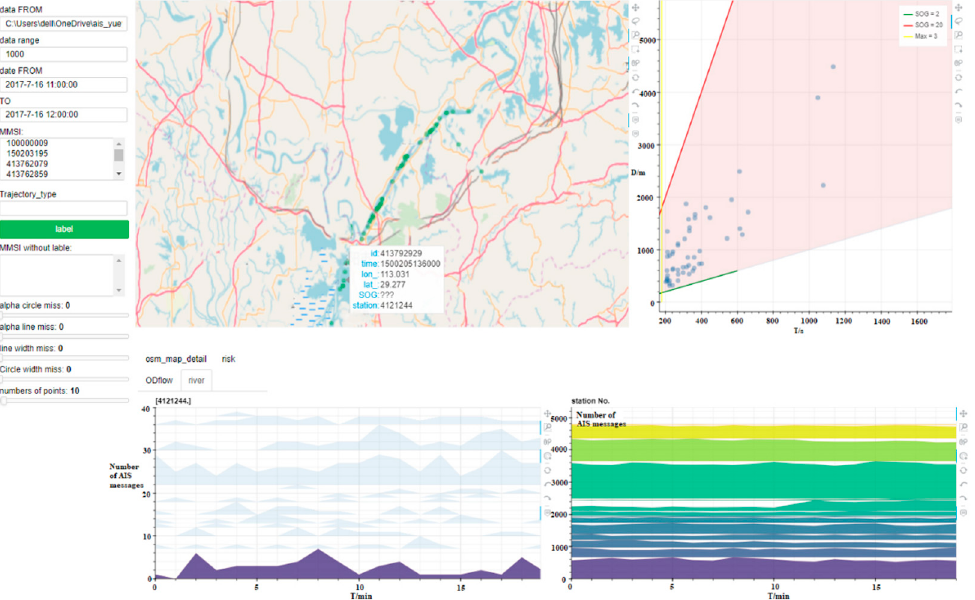
Figure 16. Distribution of missing data.